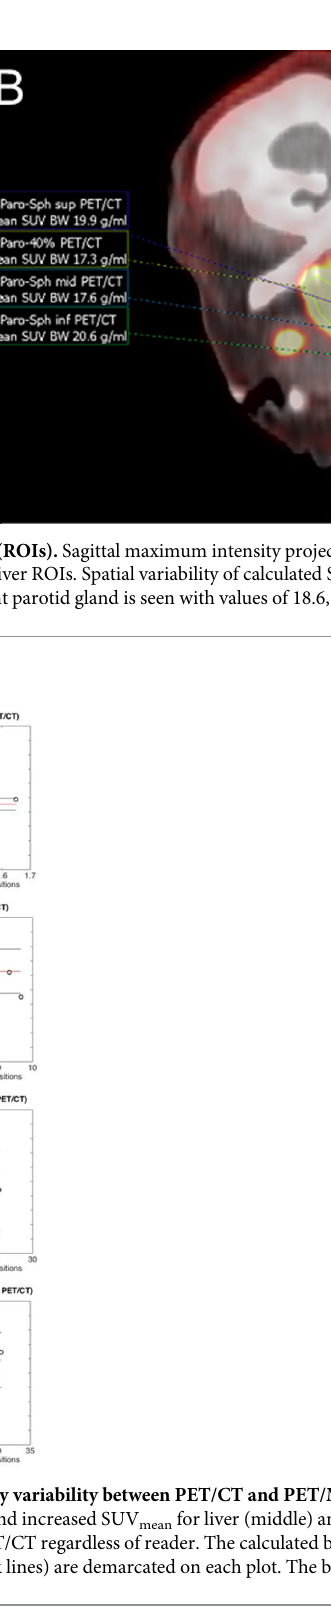
https://doi.org/10.1371/journal.pone.0283830.g003